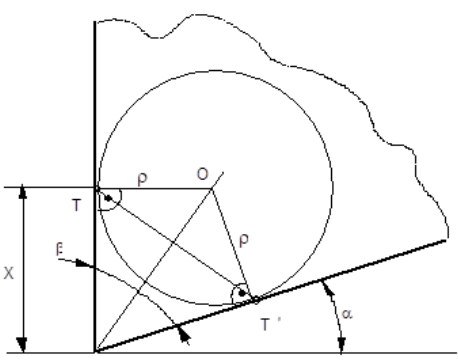
Figure 8. Cross-section image from the cutting insert.